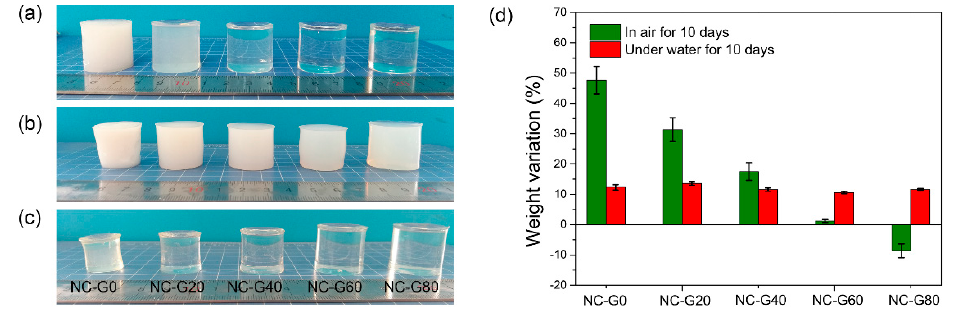
Figure 3. The digital pictures of NC-G gels. ( a ) As-prepared, ( b ) immersed in water for 10 days, ( c ) placed in air for 10 days, ( d ) weight variation of NC-G gels.